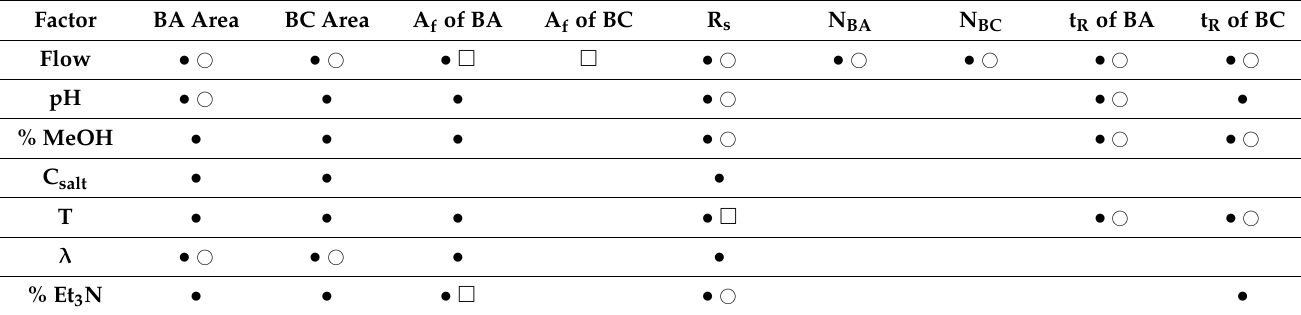
Table 6. Summarization of the statistically significant factors using the statistical interpretation ( • ), graphically significant factors ( ) and graphically potentially significant factors ( (cid:3) (cid:35)